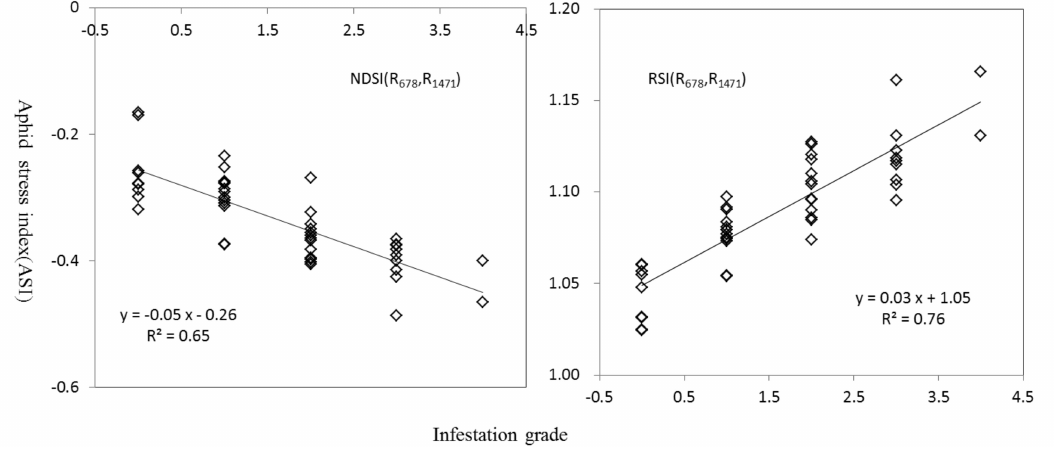
Figure 4. Regression of aphid infestation grades with the aphid stress